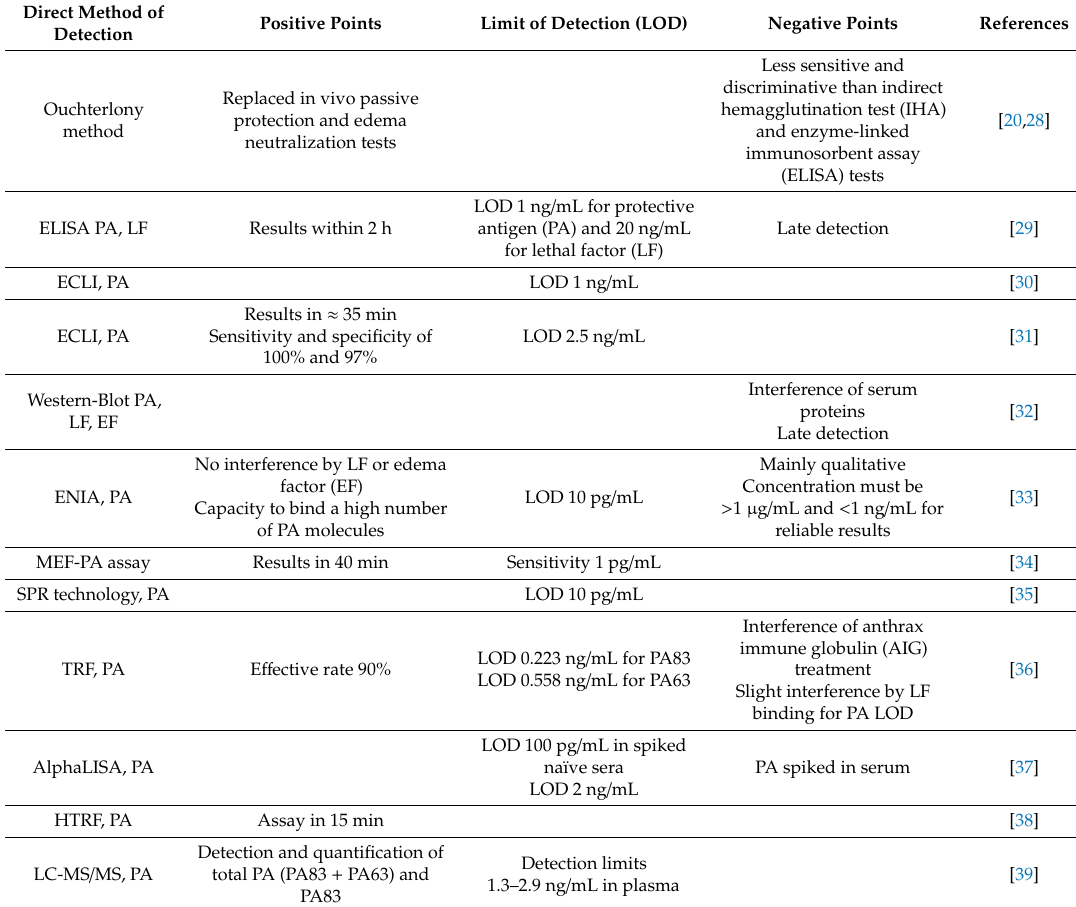
Table 1. Comparison of the direct assays for the detection of anthrax